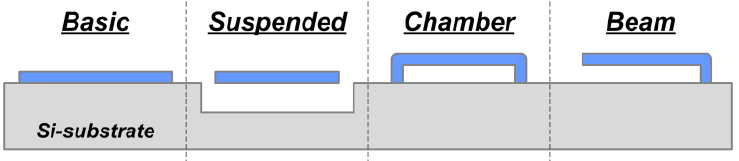
Figure 1. Schematic of four sensing-structure types (cross-section